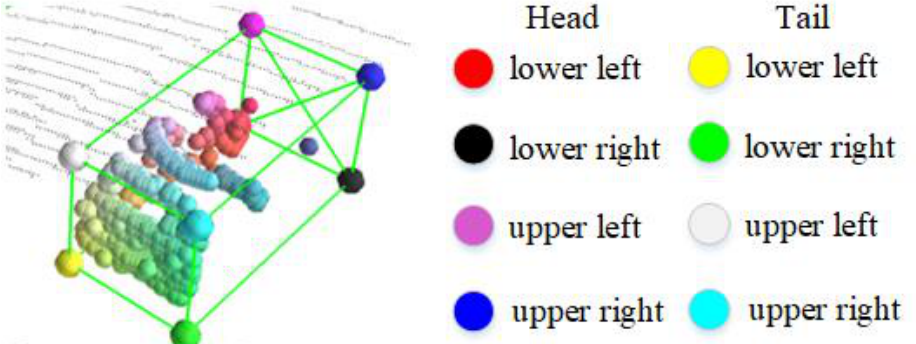
Figure 13. Intra-object part location and segmentation